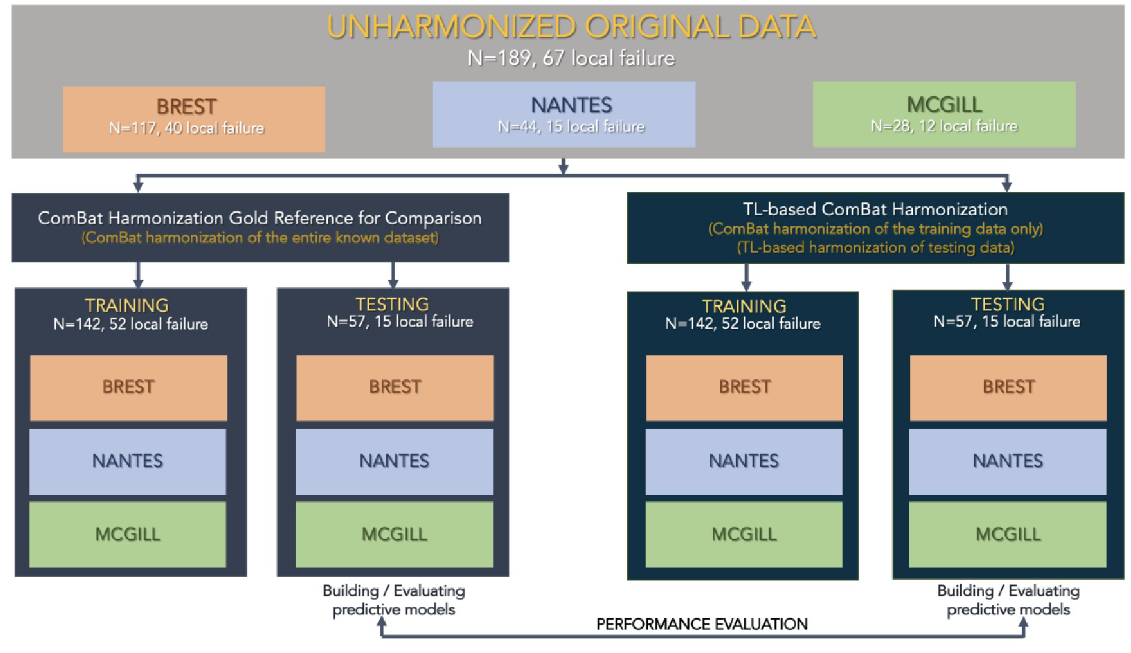
Fig 1. Workflow for the analysis in LACC datasets’